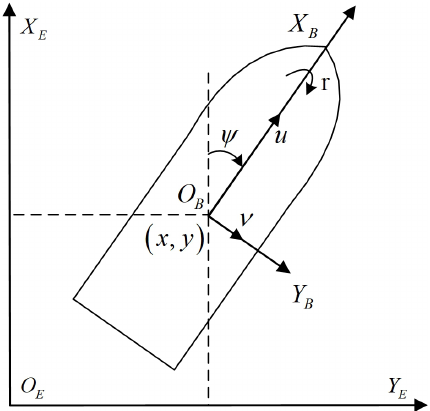
Figure 5. Earth-fixed frame and body-fixed